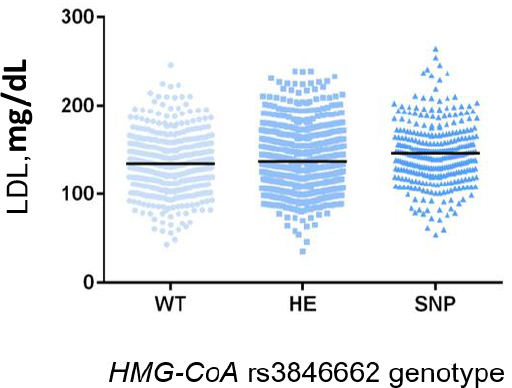
Figure 1. Association of the functional variant in HMG-CoA gene (rs3846662) with TC level in a subset of the Brisighella Heart Study population. Black lines represent TC mean value.